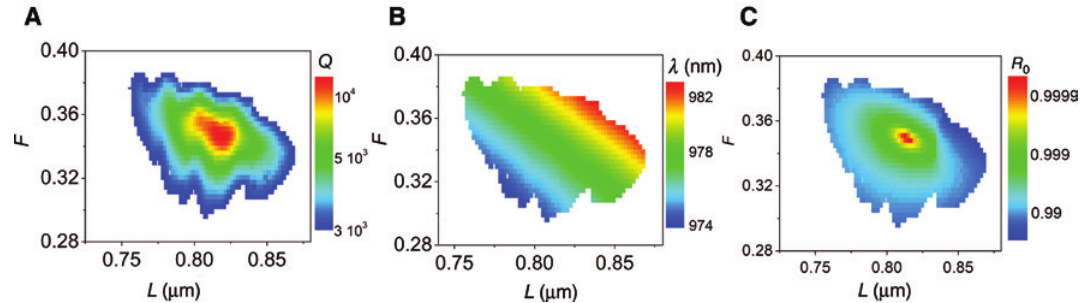
Figure 4: (A) Q -factor and (B) resonant wavelength of M-D microcavity and (C) power reflectance of MHCG mirror. (A) Q -factor values, (B) resonant wavelength ( λ ), and (C) power reflectance ( R ) for 0-DO in the domain of the MHCG period ( L ) and duty cycle 0 = 164 ( F ) for the M-D microcavity cavity when h M